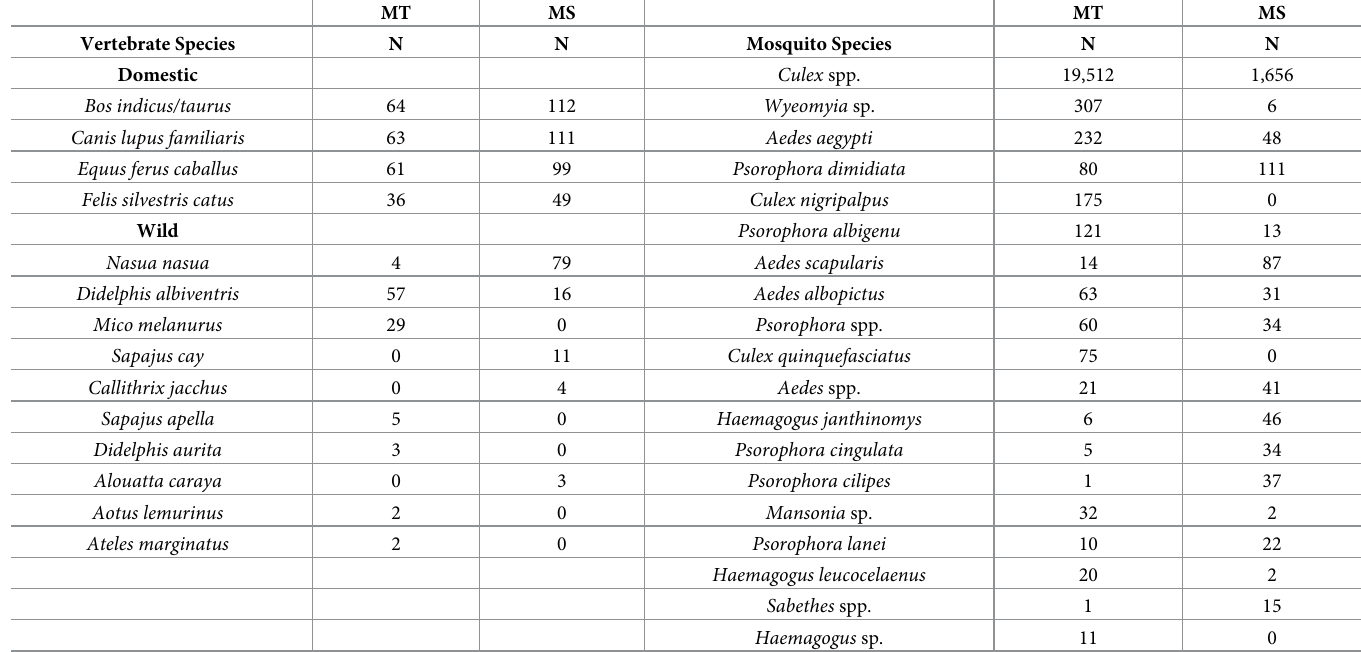
Table 1. Non-human vertebrates and mosquitoes sampled in central-western Brazil between 2017 and 2018 and tested for OROV and MAYV, by state. MT, state of Mato Grosso; MS, state of Mato Grosso do